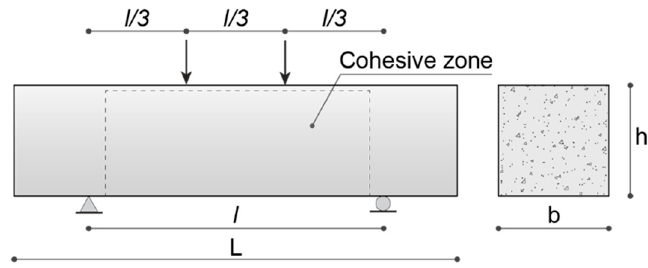
Figure 4. UHPFRC beam geometry and boundary conditions of the four-point bending test.